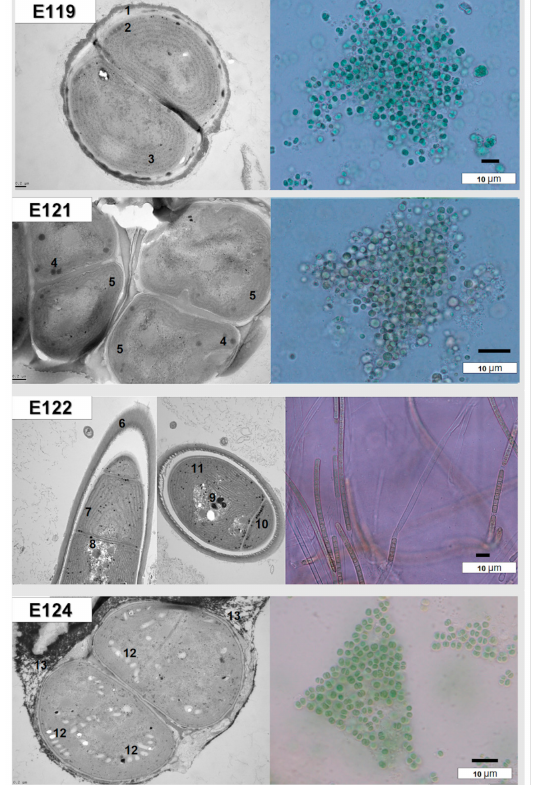
Figure 6. Morphology and cells’ ultrastructure of cultured cyanobacteria: (E119, E124) Gloeocap- sopsis sp., (E121) Chroococcidiopsis sp. and (E122) Wilmottia sp. 1,13—cyanobacterial sheaths with pigment, 6—colorless cyanobacterial sheath 2,8—polyphosphates’ granules, 3,5,7—thylakoids, 4,9— carboxysomes, 12—aerotopes, 10—granules of